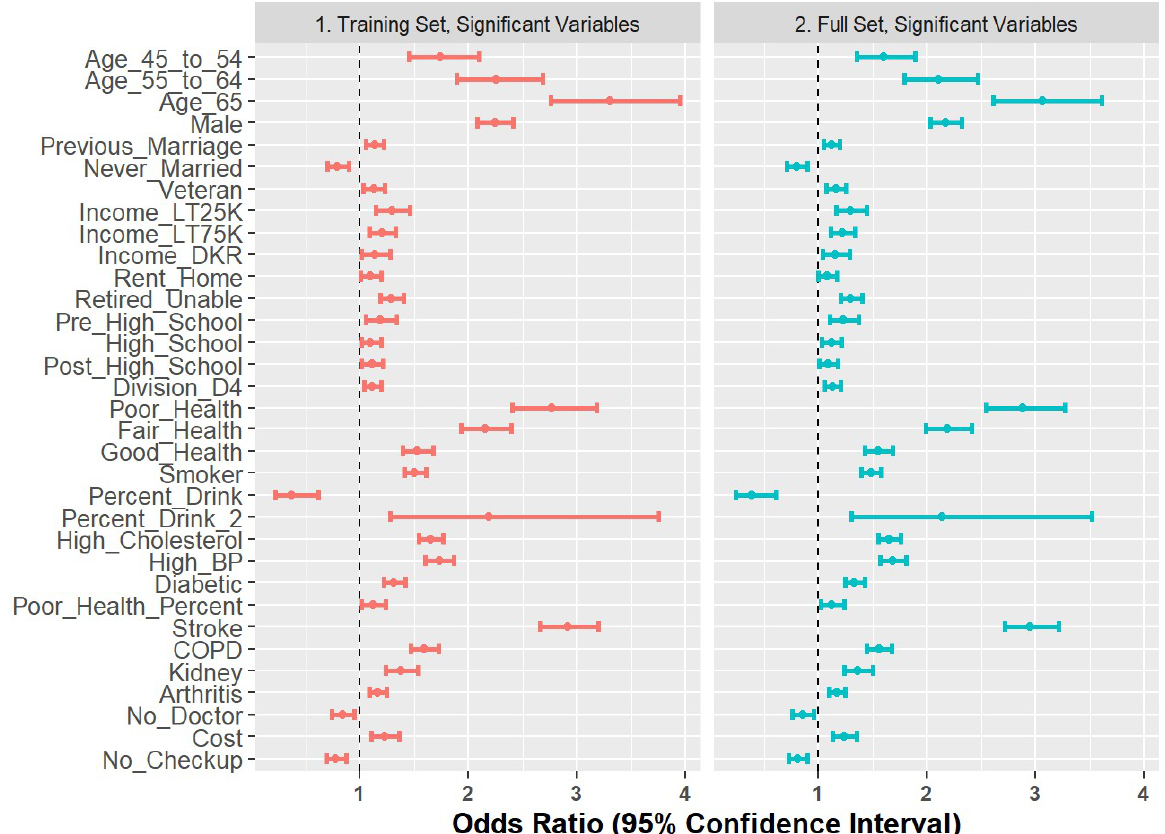
Figure 7. Forest plot of odds ratios for 80% training set versus full set of observations.